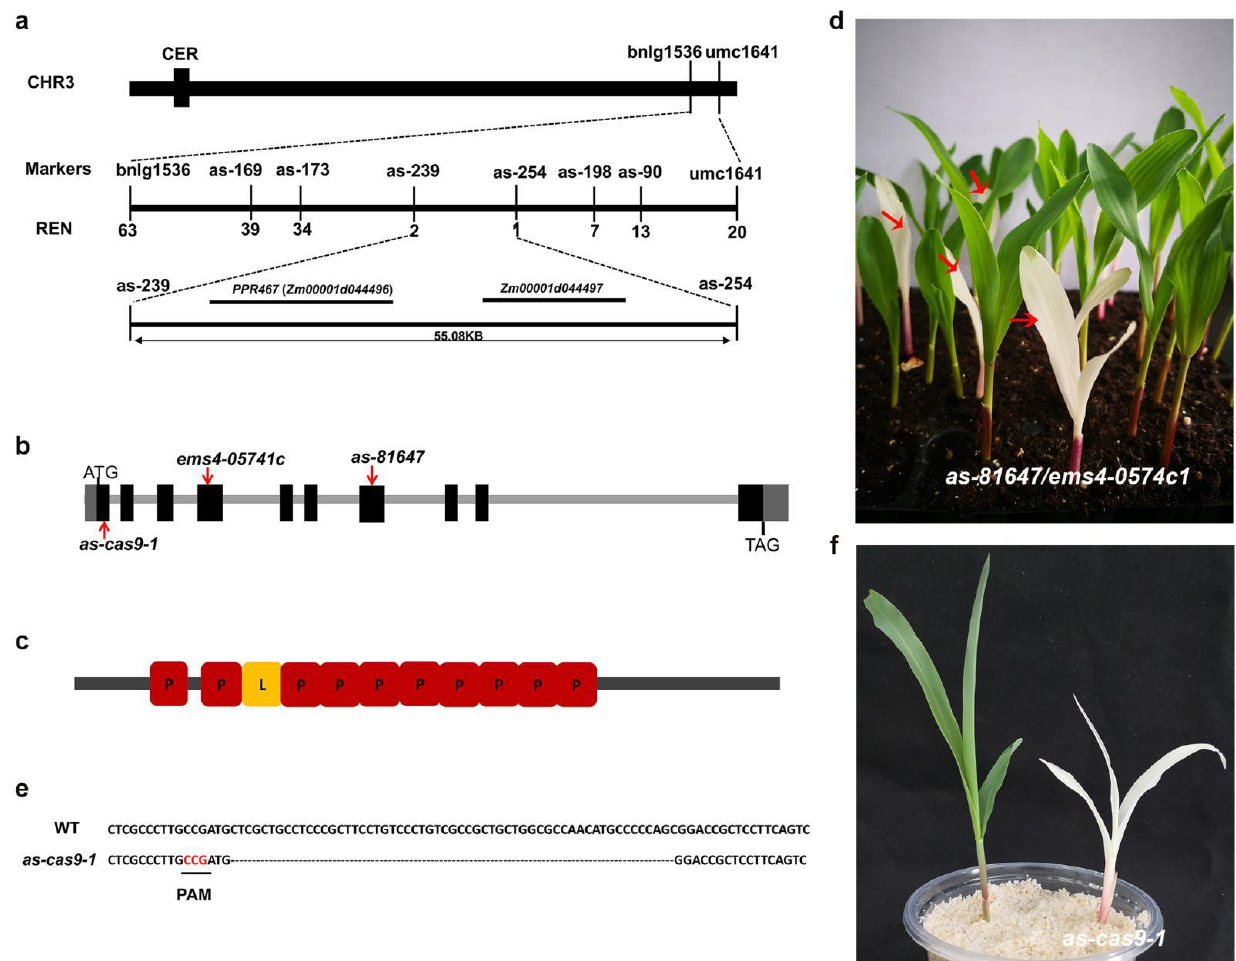
Figure 3 . Map-based cloning of AS-81647 . ( a ) Gene mapping of AS-81647 . CER, Centromere. ( b ) The predicted motif structure of the PPR647 protein, P or P-L-S block motifs are depicted as boxes with letters as indicated; P, L designates PPR, PPR-L motifs, respectively. ( c ) Structure of PPR647 and the mutation sites within two alleles. Introns and exons were shown as solid lines and boxes, respectively. ( d ) Phenotypic analysis of the allelism test between +/ as-81647 and +/ ems4-05741c . The red arrows indicate the mutant plants. ( e ) Sequence alignment of the edited sites of PPR647 in the first exon. PAM, adjacent protospacer motif. ( f ) The seedling phenotype of as-cas9-1 .